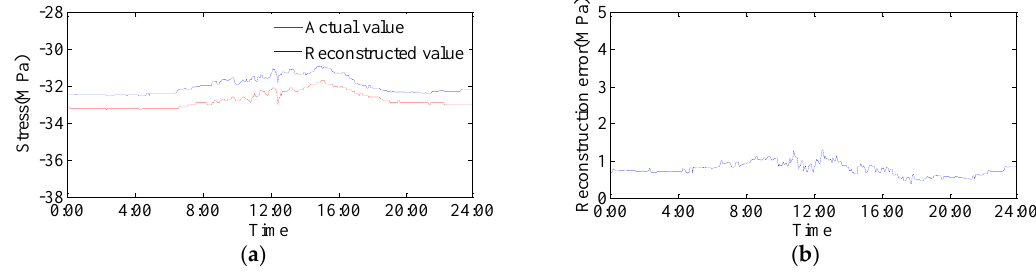
Figure 10. The reconstructed value and actual value using response variables X P 6 : ( a ) the curve of the reconstructed value and the actual value; and ( b ) the curve of reconstruction error.